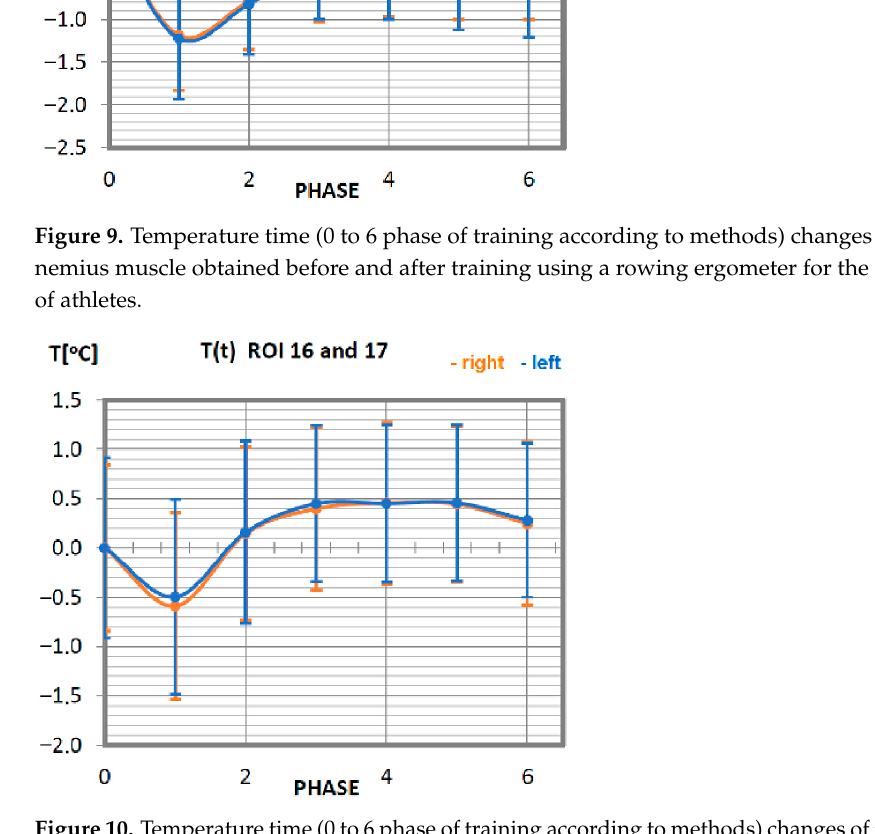
Figure 9. Temperature time (0 to 6 phase of training according to methods) changes of the gastrocnemius muscle obtained before and after training using a rowing ergometer for the studied group of athletes.